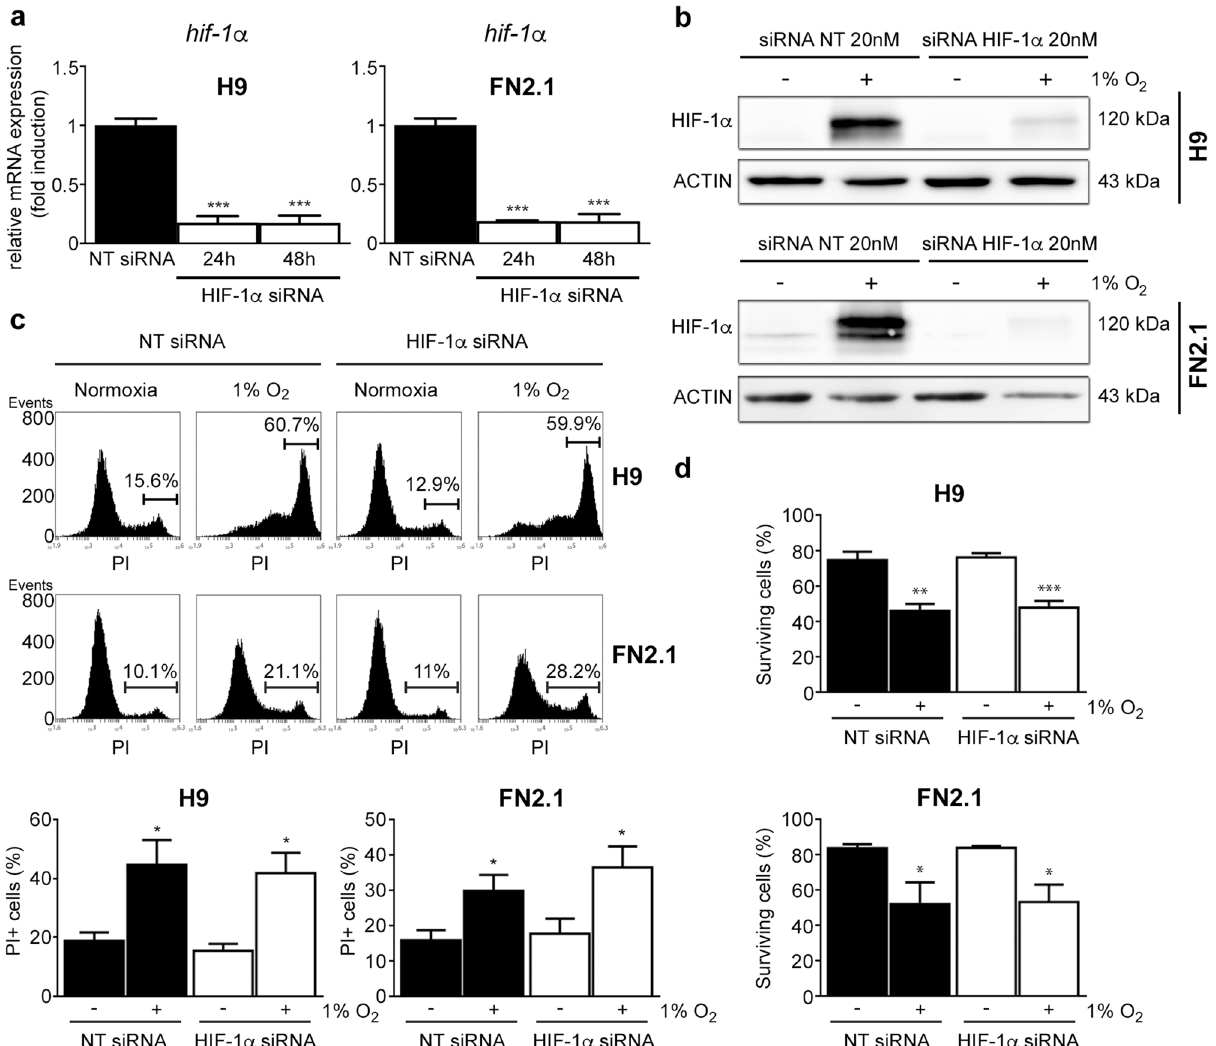
Figure 4. Effect of siRNA-mediated down regulation of HIF-1α in hPSCs cell viability and death upon 1%